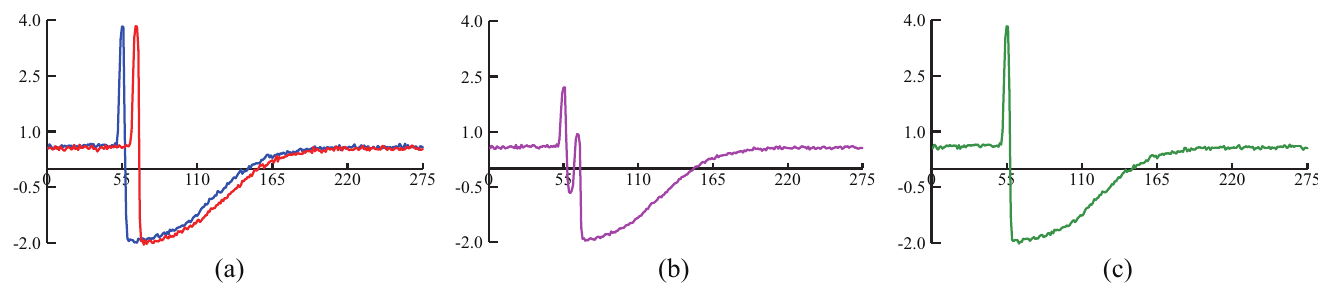
Figure 3. ( a ) two shifted time-series collected from the UCR archive. ( b ) the resulting average sequence when averaged under the Euclidean Distance. ( c ) the resulting average sequence when averaged under the DTW distance using DBA